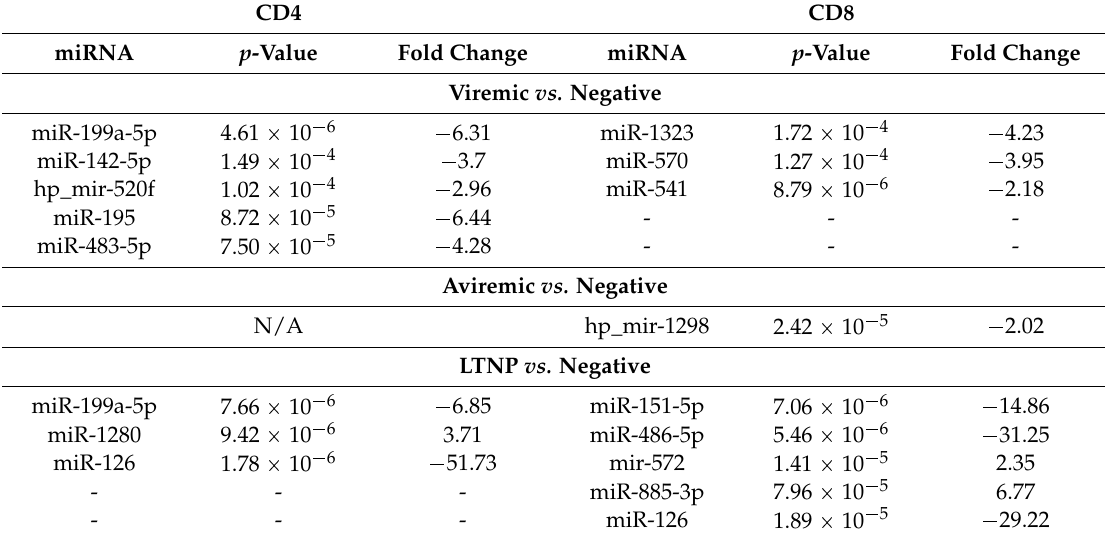
Table 7. DE miRNAs in viremic, aviremic, and LTNP cells, both CD4+ and